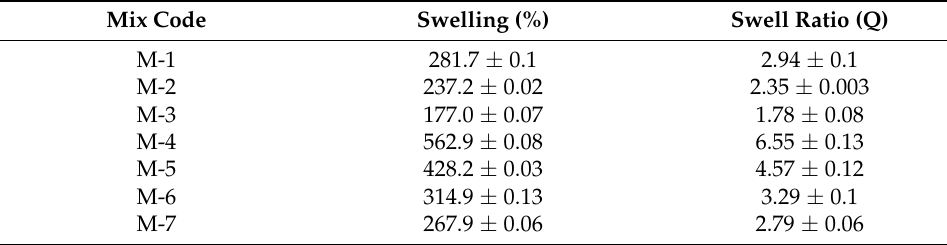
Table 3. Percentage swelling and swell ratio.